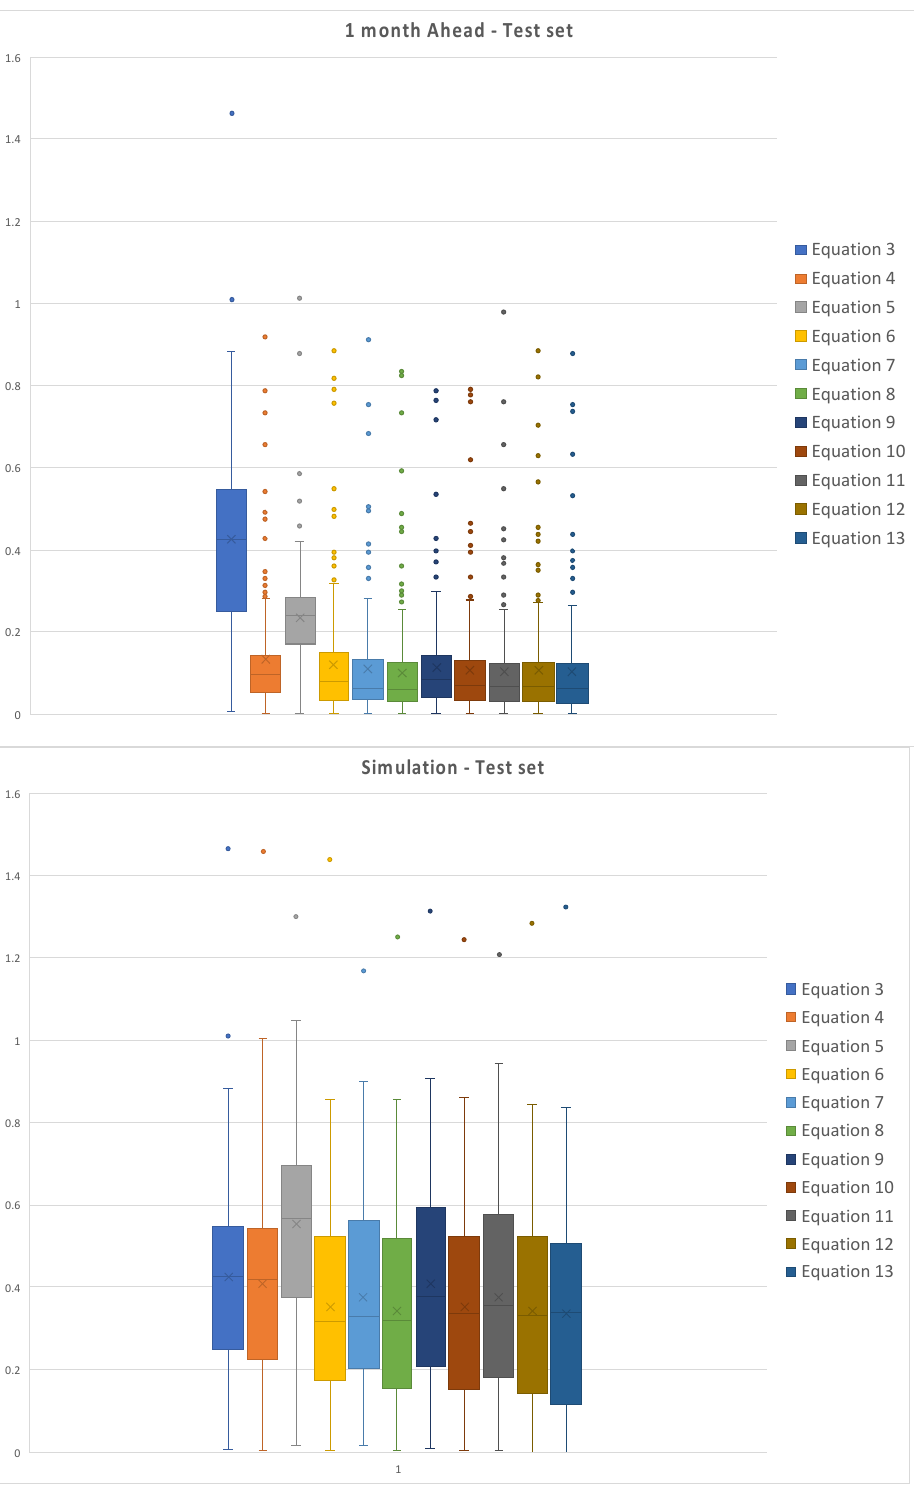
Figure 7. Box plot of the absolute values of errors of the test set for one month ahead and simulation.